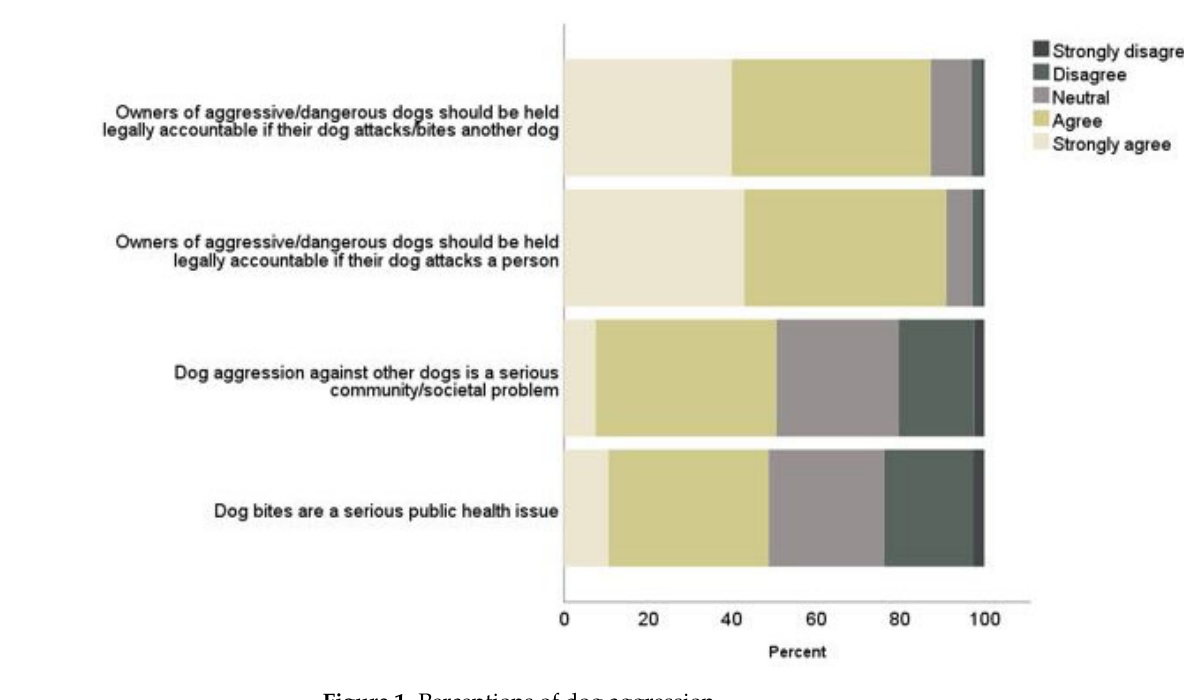
Figure 1. Perceptions of dog aggression.